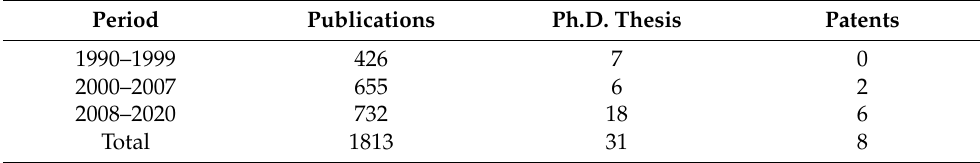
Table 5. Scientific productivity of the SARTI-UPC group.